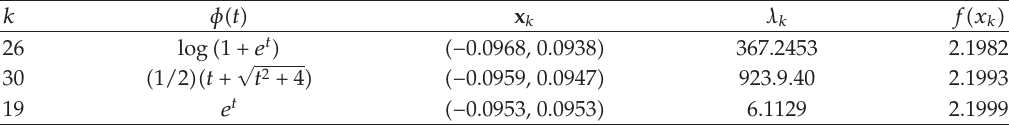
Table 1: Numerical results of Example 4.1.